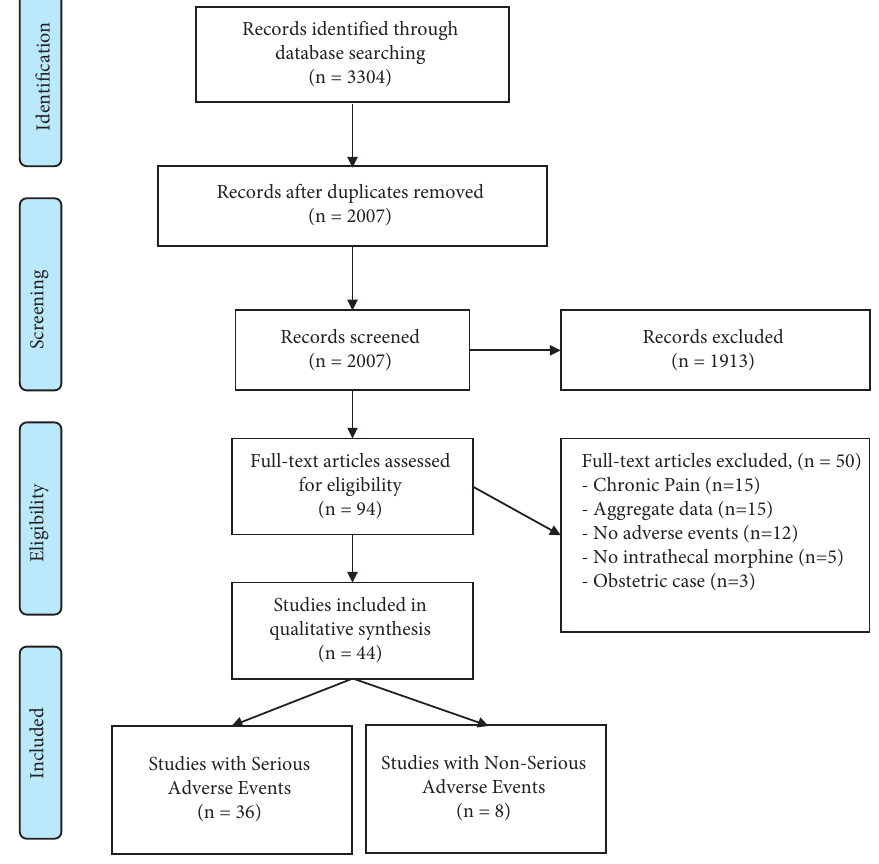
Figure 1: Flow diagram of the systematic review. Table 2: Data from the review of